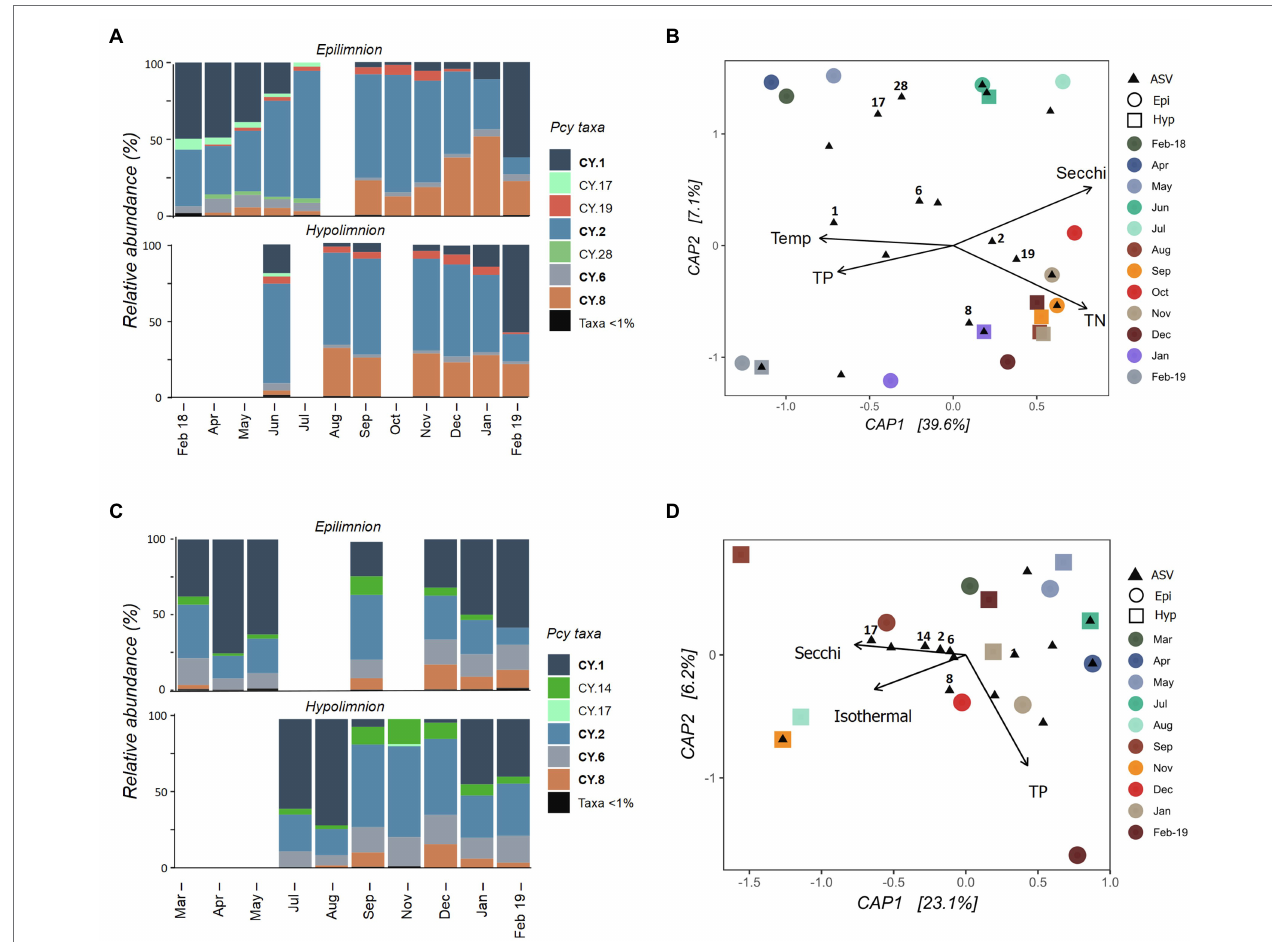
FIGURE 5 | Picocyanobacterial communities in Lake Wanaka (A,B) and Wakatipu (C,D) from February 2018 to February 2019. (A,C) show relative abundances of dominant picocyanobacterial amplicon sequence variants (ASVs) in the epi- and hypolimnion throughout the year with rare ASVs (>1% read abundance per sample) grouped together. Taxa labelled in bold indicate ASVs that are shared in at least one other study lake. Blank bars are due to insufficient cyanobacterial reads. (B,D) are canonical analyses of principal coordinates (CAP) with picocyanobacterial sample communities (circles are epilimnion samples, squares are hypolimnion samples) and ASVs (black triangles), constrained by selected environmental variables. Abundant ASVs (>1% abundant per sample) are numbered. Pcy, picocyanobacteria; TN, total nitrogen; and TP, total